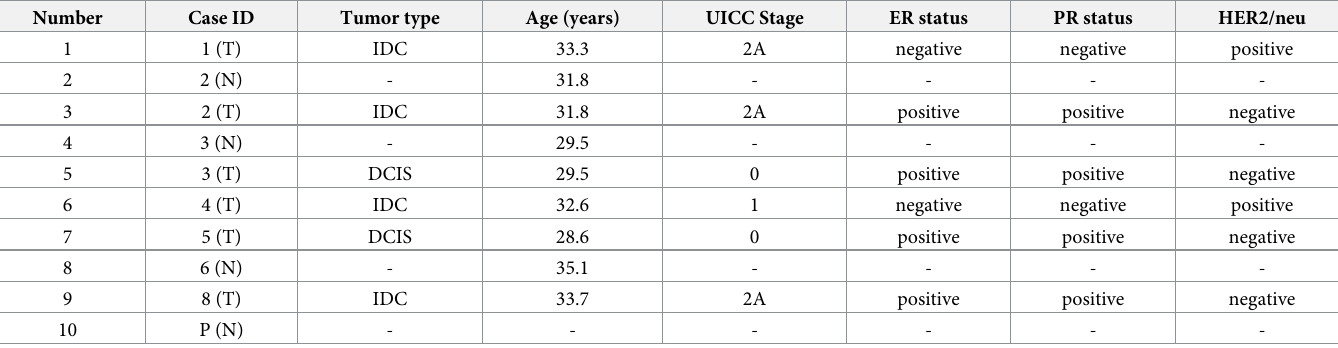
Table 1. Clinicopathological parameters of subjects analyzed by miRNA microarray.